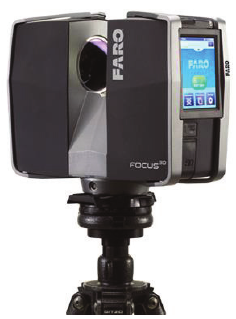
Figure 8: The FARO Focus 3D terrestrial laser scanning system.